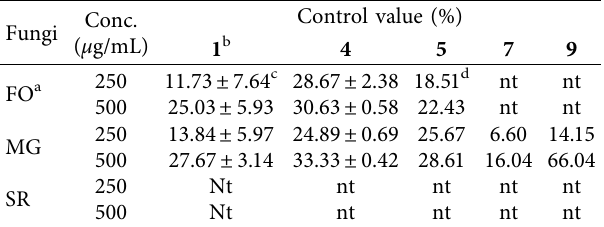
Table 1: Control value (%) of limonoids 1 , 4 , 5 , 7, and 9 against Fusarium oxysporum , Magnaporthe oryzae , and Sclerotium rolfsii . Fungi